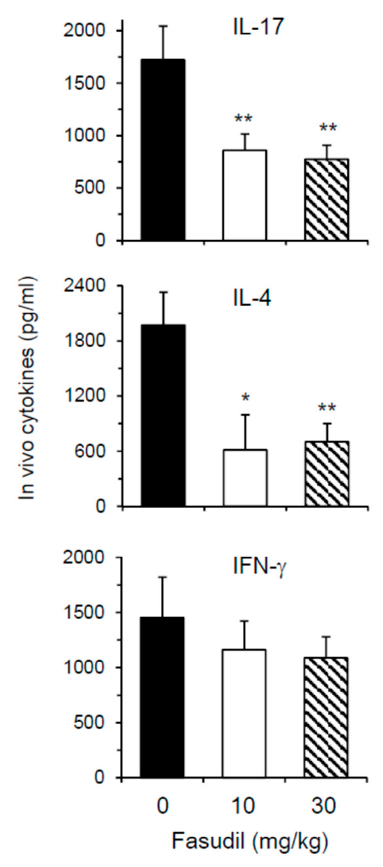
Figure 5. Fasudil reduces in vivo Th17 and Th2 cytokine post-infection. Mice were infected with S. japonicum and injected i.p. with fasudil at 0, 10 and 30 mg / kg for 5-weeks (d 21–d 56). The levels of IL-17, IL-4, and IFN- γ in the peripheral blood were assayed at 8 weeks post-infection by IVCCA. Results ( n = 5–8 per group) are representative of two independent experiments. * p < 0.05, ** p < 0.01 vs. PBS-injected mice.